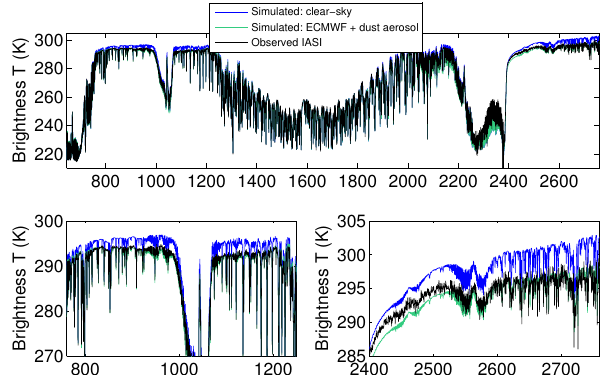
Figure 7. As Fig. 6, with a second spectrum acquired on 3 July (low aerosol